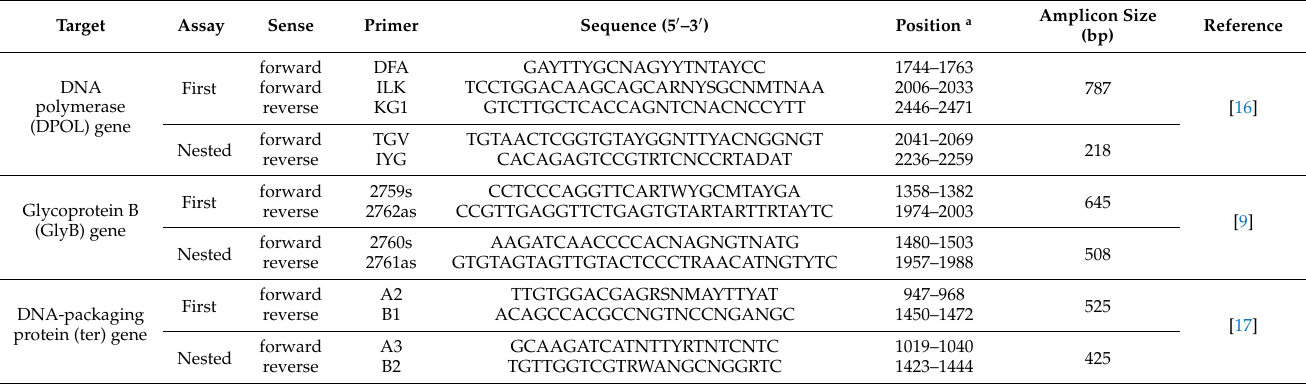
Table 1. Primers used for the amplification and sequencing of the gammaherpesvirus partial